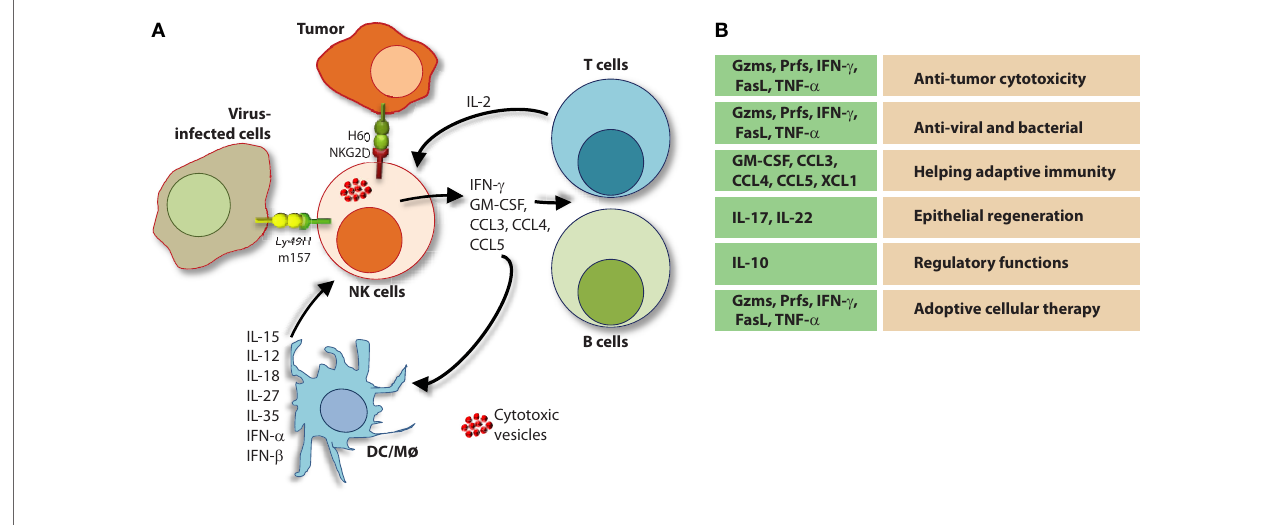
FiGURe 7 | Role of a “third signal” in natural killer (NK) cell activation. (A) A brief description of the significant interactions between NK and myeloid cells. NK cells possess inherent abilities to mediate cytotoxicity and produce inflammatory cytokines and chemokines. Myeloid cell-derived cytokines play a central role in regulating the effector functions of NK cells. Interactions between the innate NK cells and the primary arms of the adaptive immunity (T and B cells) are less explored. Stimulation through activation receptors (i.e., NKG2D or Ly49H) help recognize tumor (H60) or infected target cells (murine cytomegalovirus-derived m157). (B) A summary of major soluble factors produced by NK cells and their intended